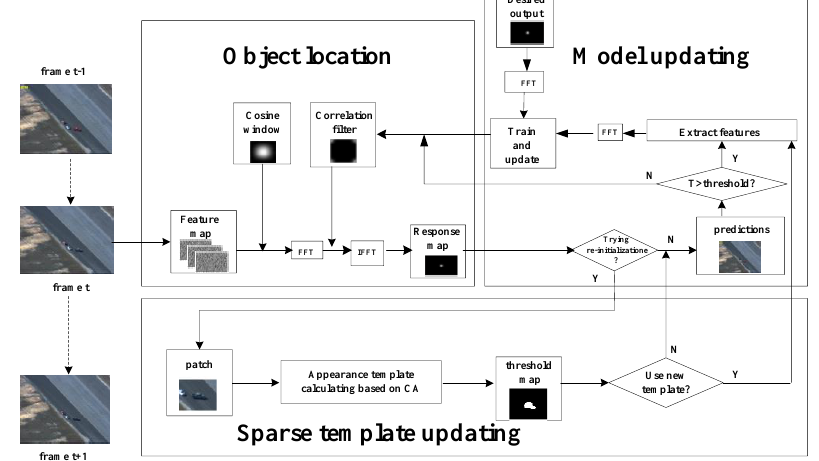
Figure 2. Flowchart of the proposed tracking algorithm.